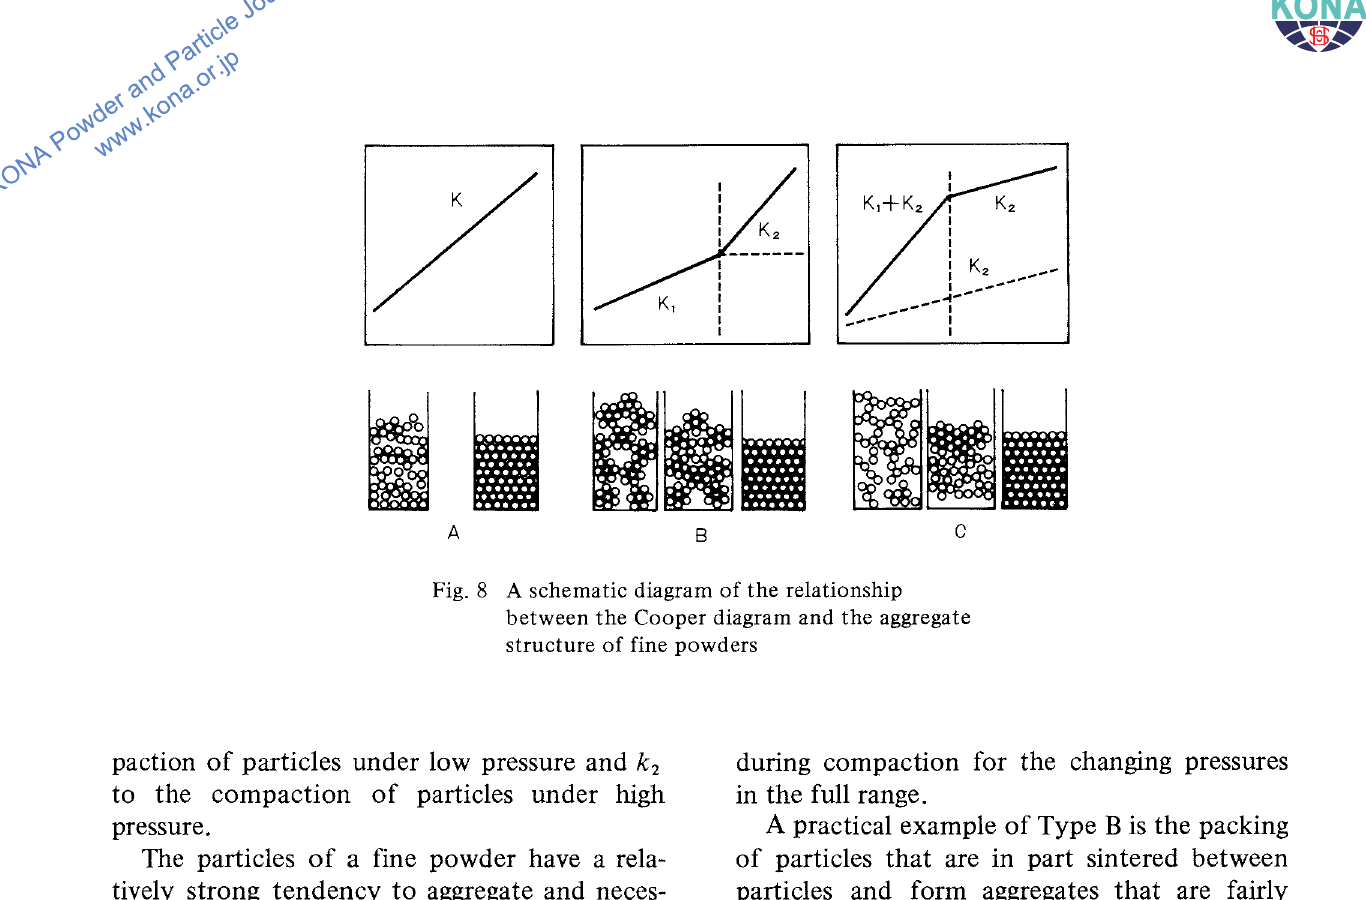
Fig. 8 A schematic diagram of the relationship between the Cooper diagram and the aggregate structure of fine